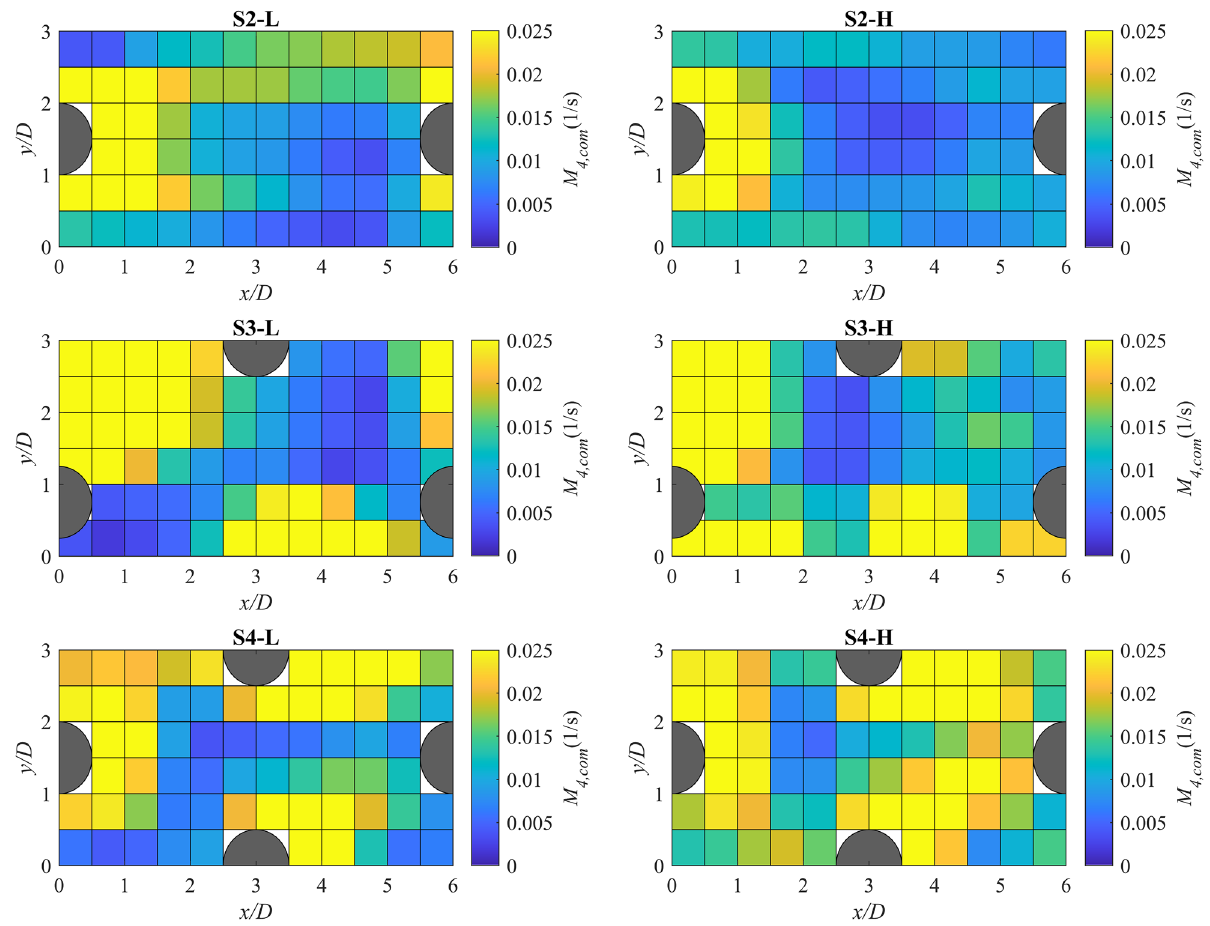
Figure 6. Contour maps of the components of modified recirculation metric, M 4,com , for scenarios with boulder placement in the detailed measurement zone for Δ s = Δ x = Δ y = 0.06 m. The blank (white) areas in the contour maps are due to the missing measuring points occupied by